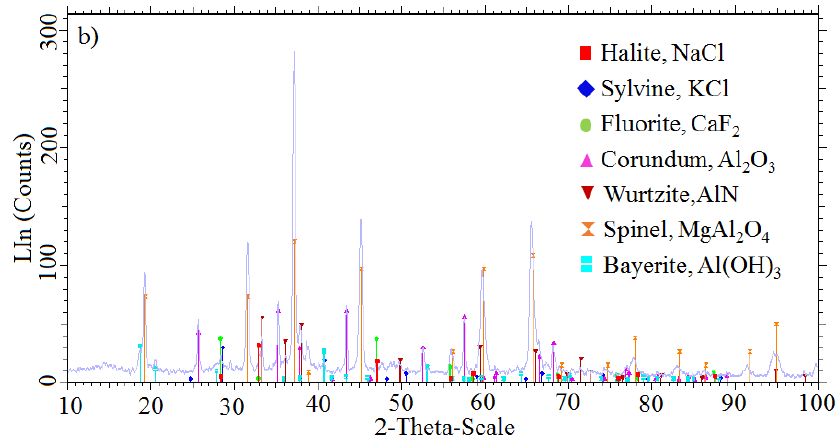
Figure 1. X-ray diffractograms of the raw materials. ( a ) SLS and CRT glass; ( b ) aluminum dross.